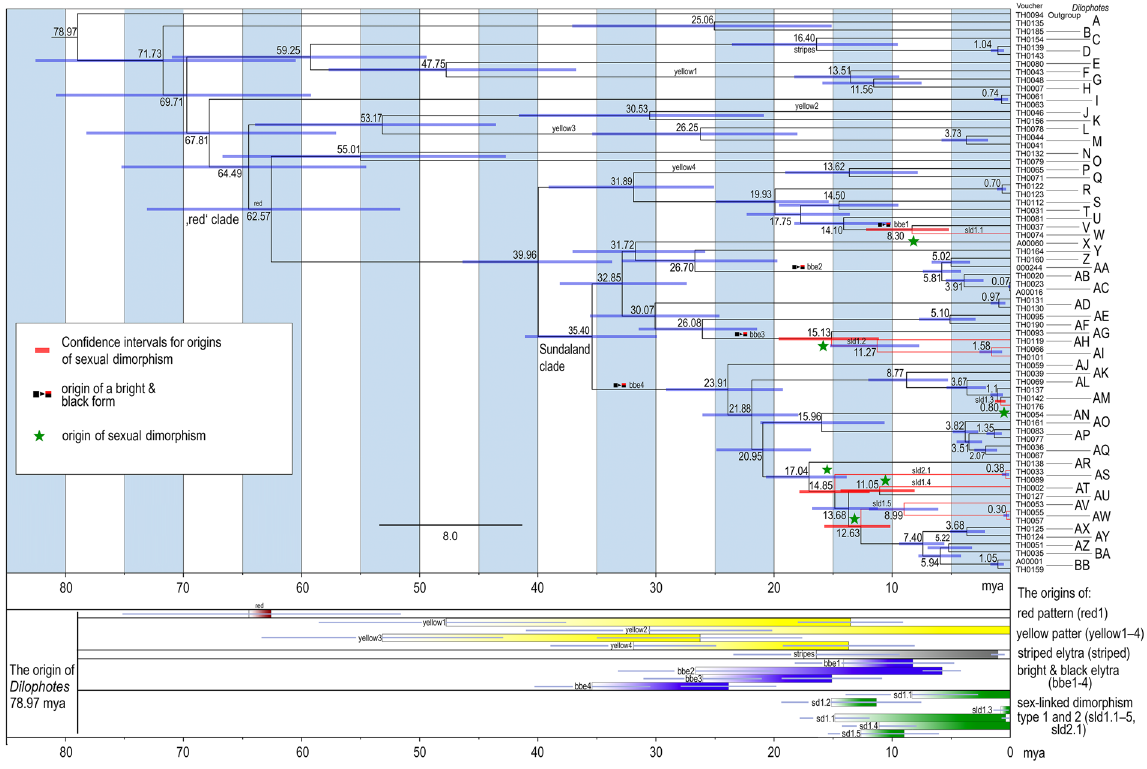
Figure 4. Dated tree with mean times of origin and 95% confidence